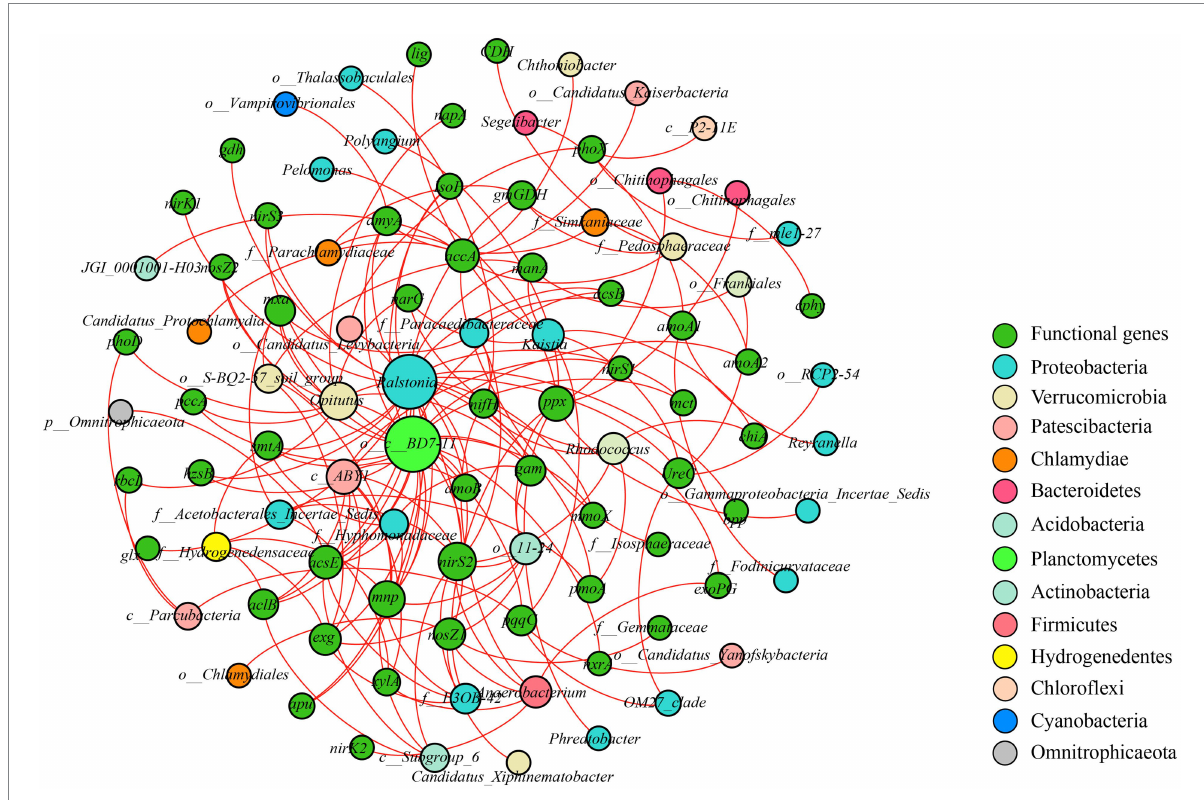
FIGURE 6 Co-occurrence network of bacterial communities and functional genes. The red links represent positive